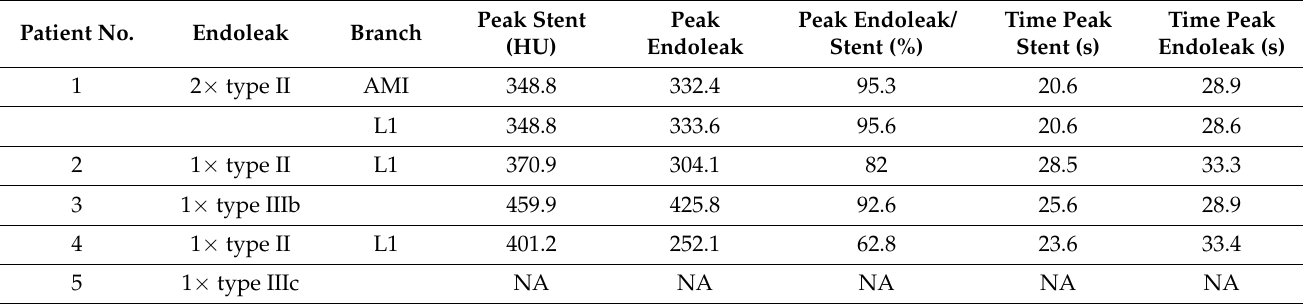
Figure 3. The time attenuation curves of the dynamic computed tomography angiography in two patients: patient 4 (type II endoleak) and patient 7 (2 × type II endoleaks). Owing to the fixed delay of 8 s after the contrast bolus, the time-to-peak of the stent varied per patient as a result of the different cardiac outputs. In patient 7, it is unknown whether the maximum peak of the endoleak was reached. Table 2. Peak attenuation curves and time to peak. *curve is not finished yet.